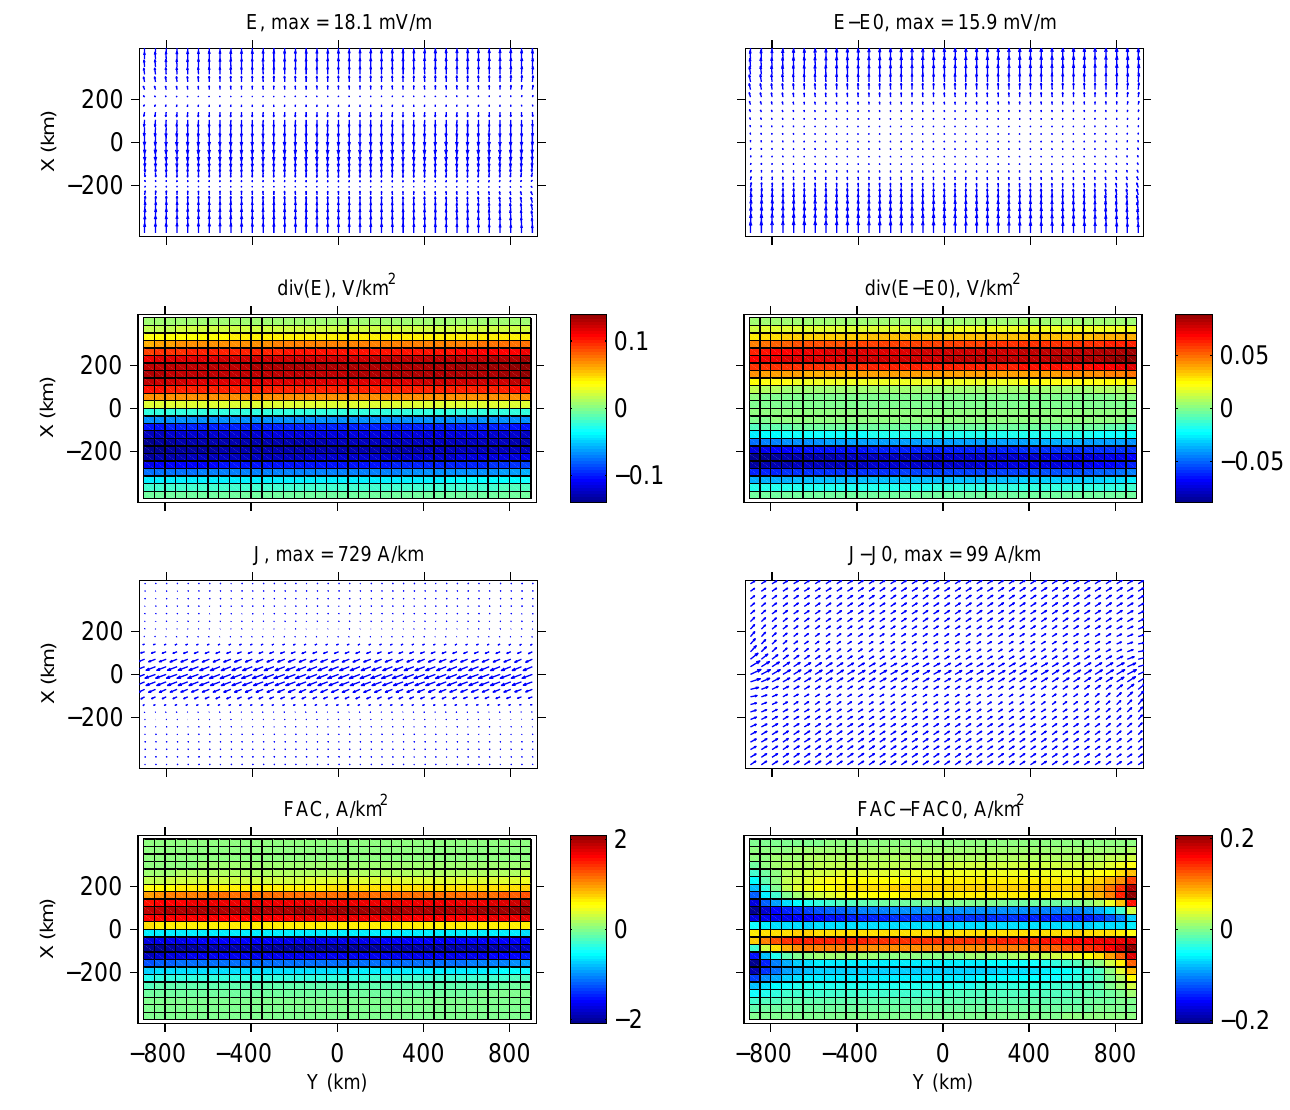
Fig. 3. KRM results for the electrojet model. At each row the KRM result is shown on the left side and the difference between the KRM result and the original model is on the right side. Rows from top to bottom are: electric field, divergence of the electric field, horizontal currents and FAC. Note the different scales of the vector